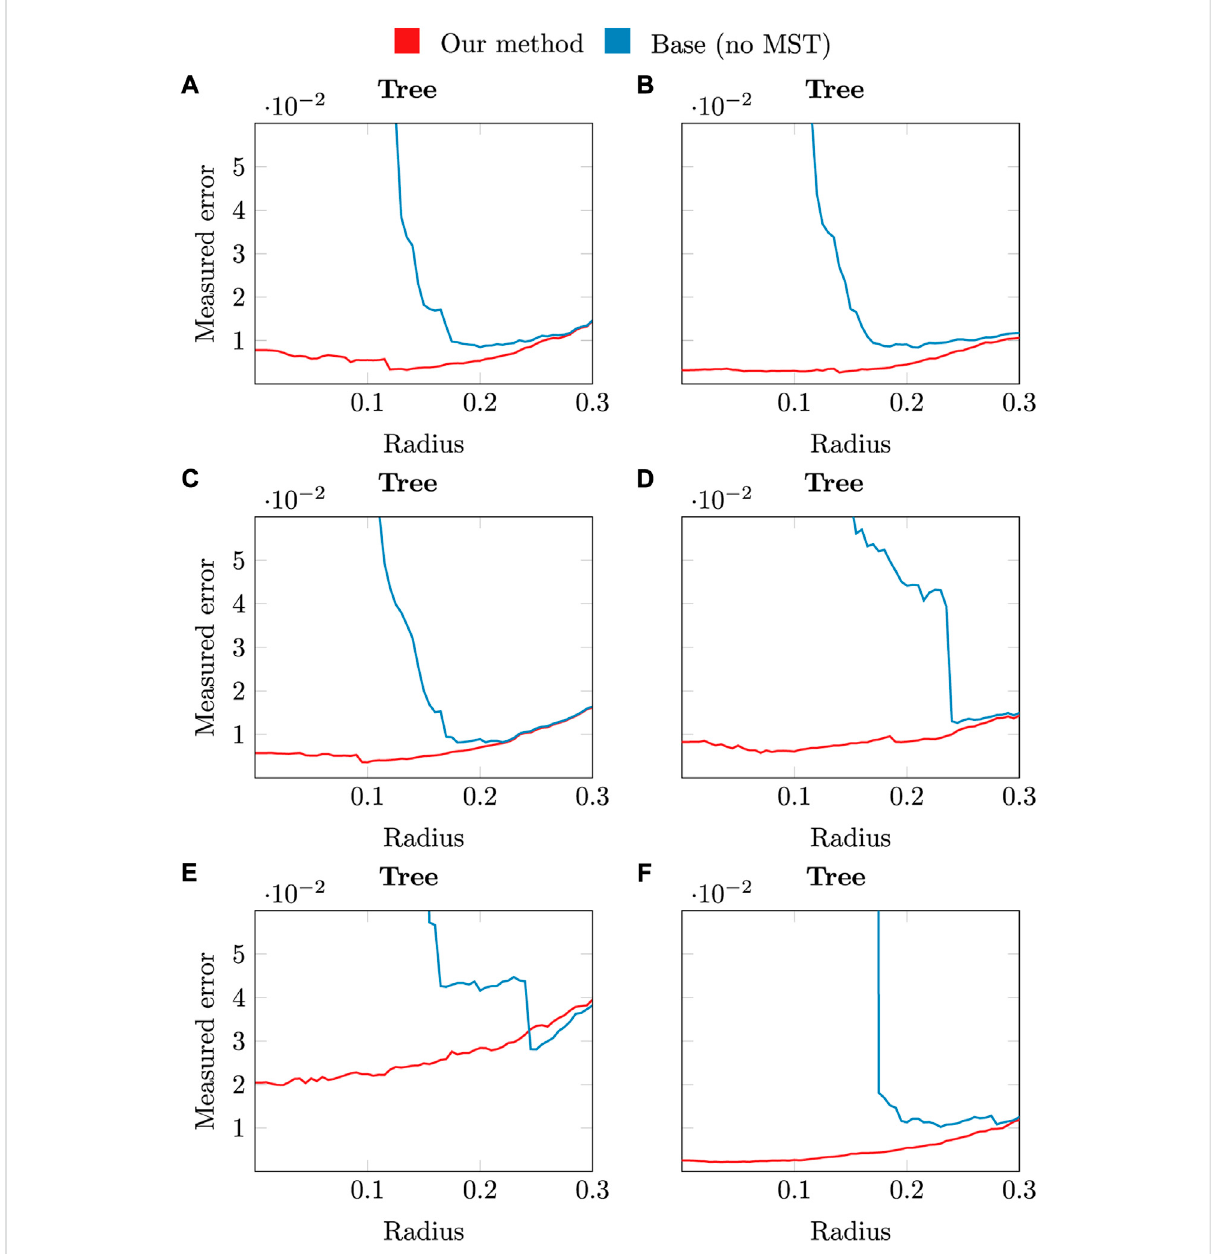
FIGURE 7 Graphical overview of the accuracy obtained by applying our method (red), or the base method (blue) with different radii.